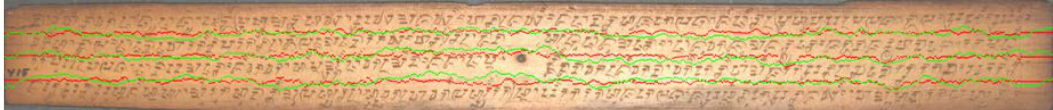
Figure 25. Text line segmentation of Sundanese manuscript with the Seam Carving method (green) and Adaptive Path Finding (red).